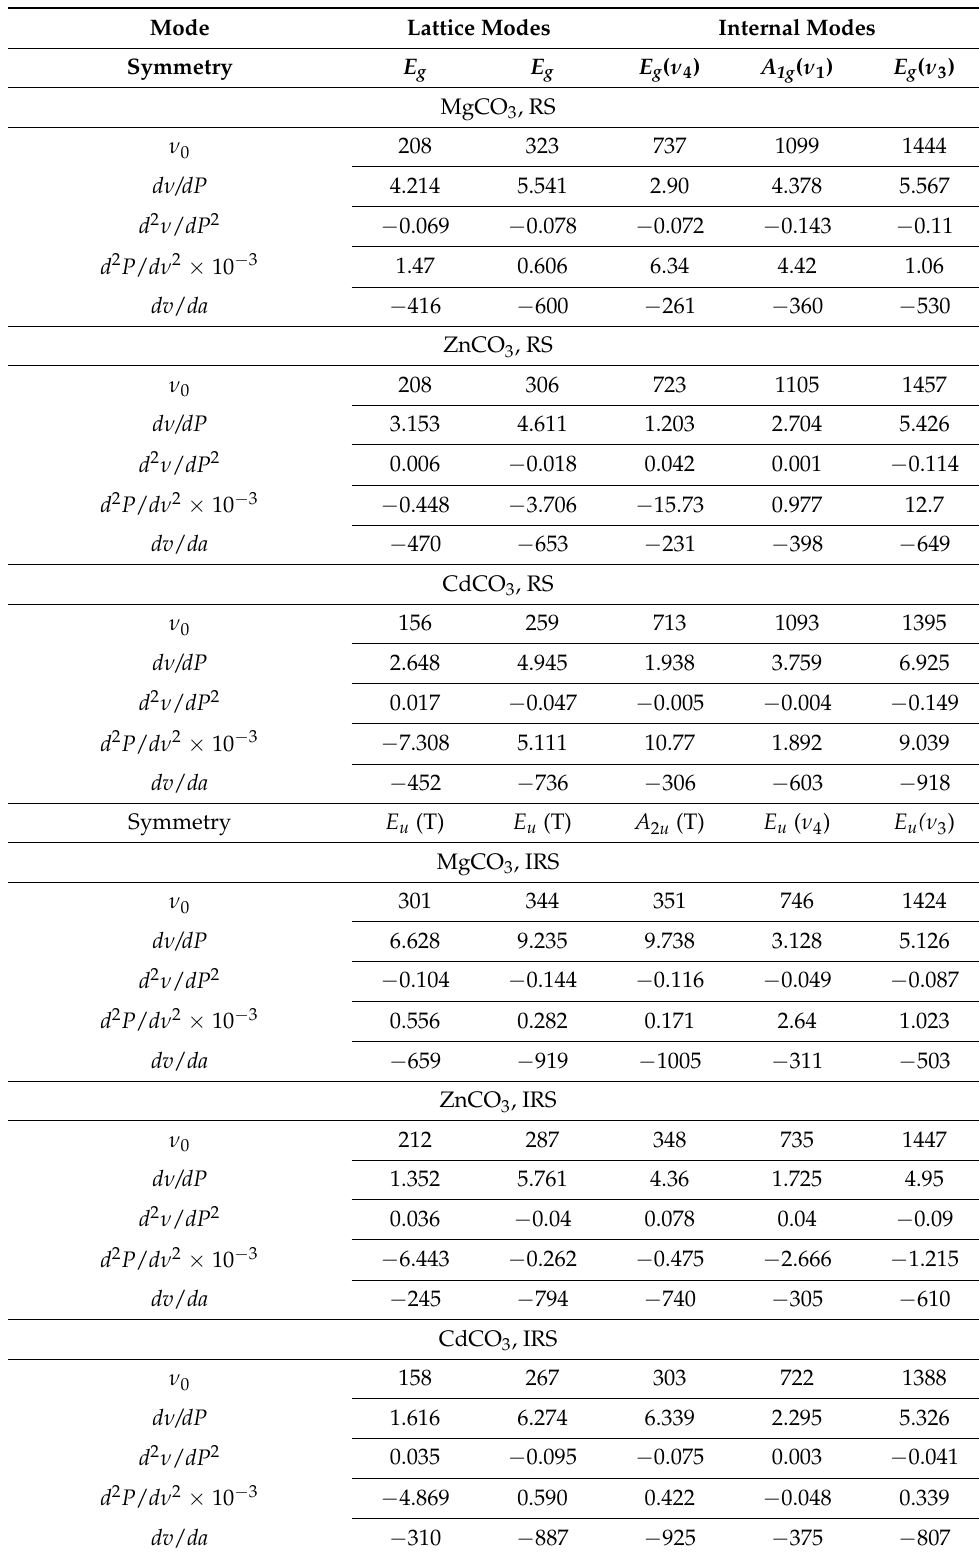
Table 4. Wavenumbers ν 0 (cm − 1 ) of the intramolecular modes active in the infrared (IRS) and Raman (RS) spectra of the carbonates with the calcite structure, their first d ν / dP (cm − 1 /GPa) and second d 2 ν / dP 2 (cm − 1 /GPa 2 )) P pressure derivatives. The second pressure derivative is given with respect to the d 2 P / d ν 2 (GPa 2 /cm − 1 ) wavenumber and the wavenumber derivative—with respect to the dv / da (cm − 1 /Å) lattice